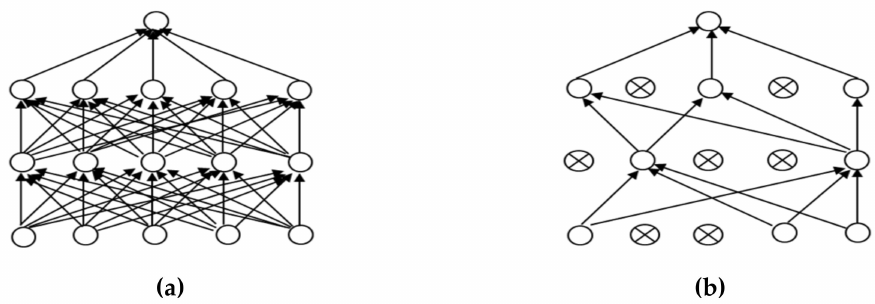
Figure 7. Dropout: ( a ) a neuron before a dropout; ( b ) a neuron after a dropout. Mish Activation